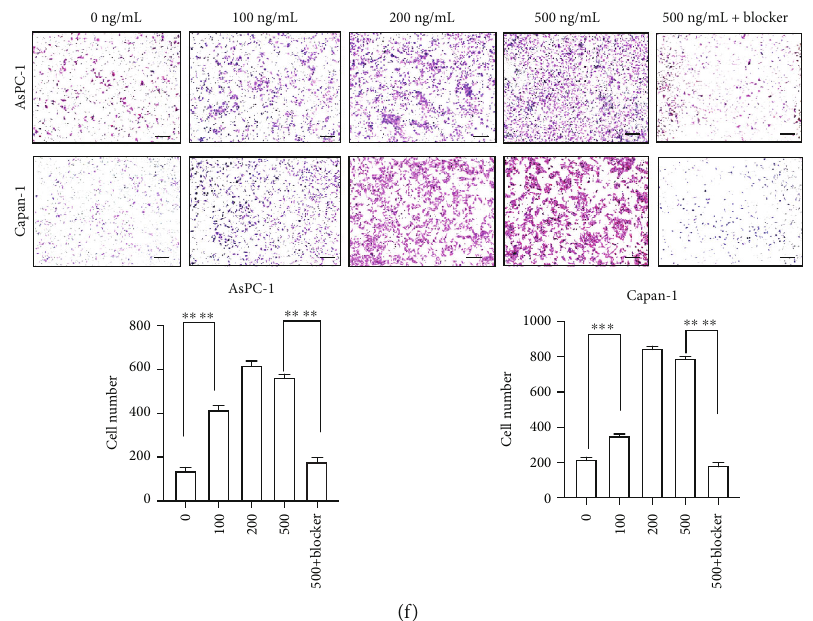
Figure 5: CX3CL1 promoted recruitment of CX3CR1-positive pancreatic tumor cells. (a) mRNA levels of CX3CR1 in PDAC cells. (b) Western blot analysis of CX3CR1 in human PDAC cell lines. (c) Flow cytometry analysis of the surface expression level of CX3CR1 in di ff erent human cell lines. (d)The expression level of soluble CX3CL1 was examined by using ELISA. Protein samples were obtained from the mouse liver. (e) E ff ect of CX3CL1 on the migratory ability of mouse PDAC cell lines Panc02; relative transferred cell numbers were analyzed. Cell migration experiments in blocker group were performed by using the blocking antibody of CX3CL1. The neutralization dose (ND ) is 1 μ g/ml in the presence of 30 ng/ml mouse recombinant CX3CL1. Scale bar 10 μ m. (f) E ff ect of CX3CL1 50 on the migratory ability of human PDAC cell lines AsPC-1 and Capan-1. Di ff erent concentration of CX3CL1 recombinant protein was used in cell transwell experiments; relative transferred cell numbers were analyzed. The neutralization dose (ND ) is 3 μ g/ml in the 50 presence of 100 ng/ml human recombinant CX3CL1. Scale bar 10 μ m. ∗ P < 0 : 05 , ∗∗ P < 0 : 01 , ∗∗∗ P < 0 : 001 , and ∗∗∗∗ P < 0 : 0001